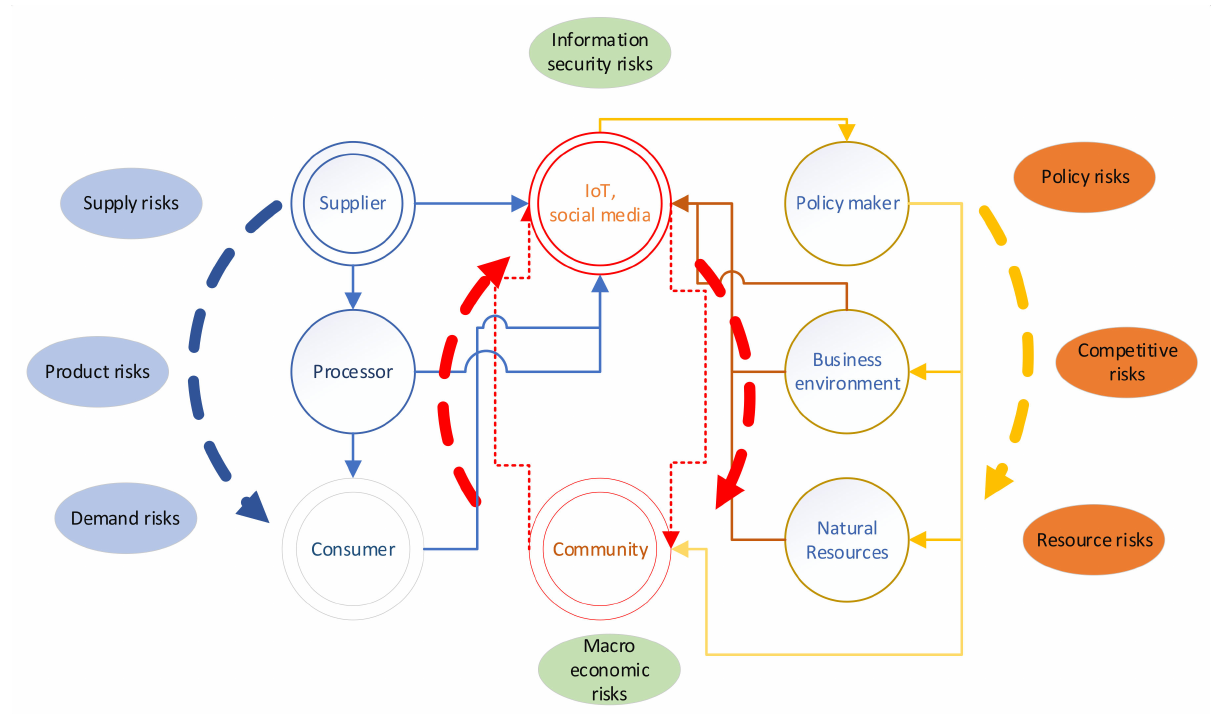
Figure 4. IoT-based supply risk chain management and information